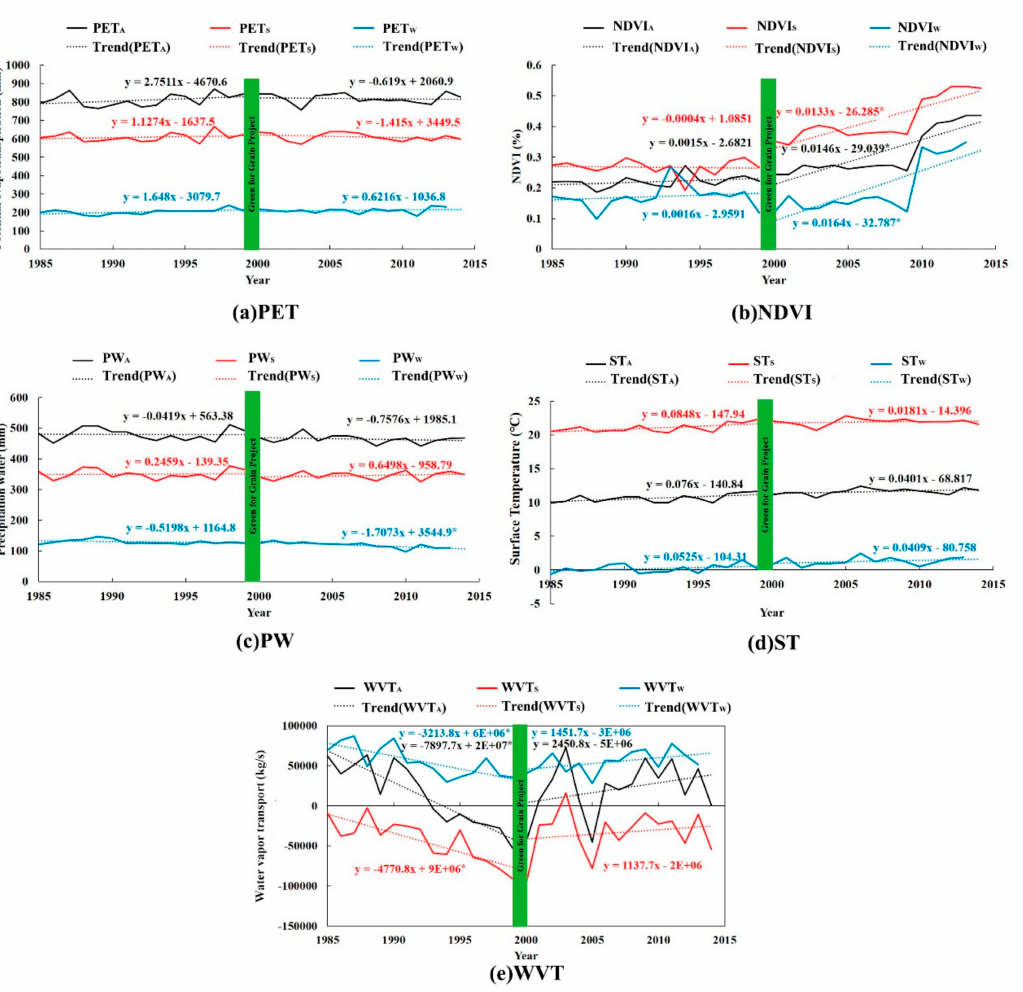
Figure 6. The annual and seasonal trend of five factors ( a ) PET, ( b ) NDVI, ( c ) PW, ( d ) ST, ( e ) WVT (“*” indicates that the trend is statistically significant at the 95% confidence